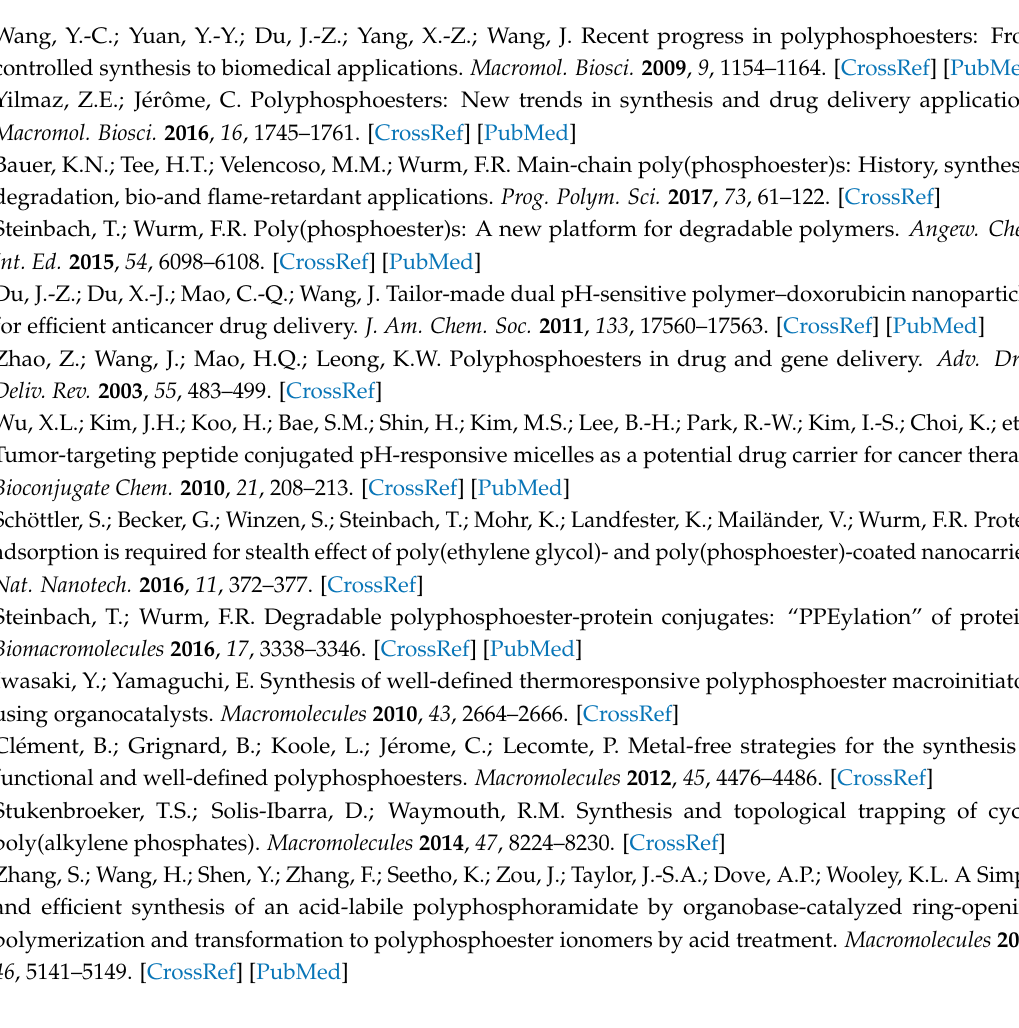
s1, Figure S1: Molecular structure of MeOEP and geometry parameters analyzed in DFT calculations, Table S1: Structural parameters of the MeOEP molecule calculated by DFT using different functional/basis sets, and deviations ∆ X from the X-ray data, Table S2: Efficiency rating for the functional/basis sets used for the MeOEP molecule calculations, part S1.2: a list of molecular structure plots, energy values, and Cartesian coordinates for the calculated stationary points and transition states, part S2: polymerization method parameters, Figures S2–S7: NMR spectra of the